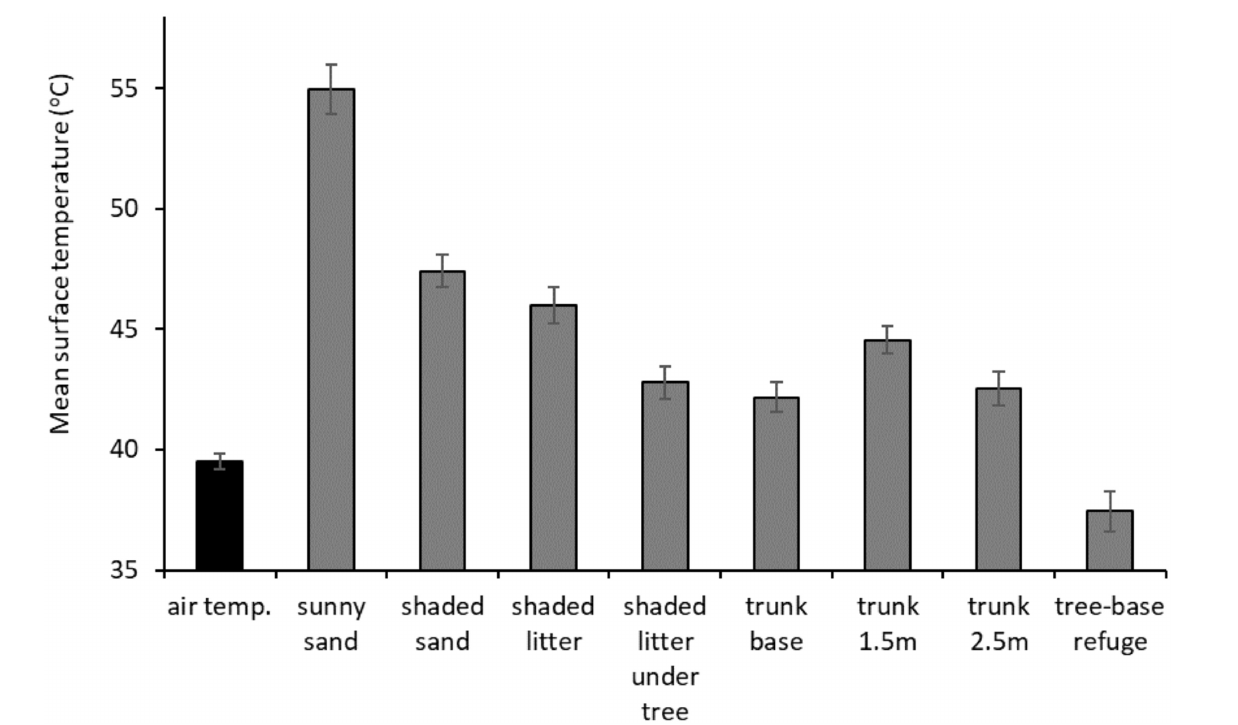
FIGURE 7 | Mean surface temperature of habitat substrates at a mean air temperature of 39.5 ◦ C on sunny afternoons. Error bars show SE. (Repeated ANOVA: F 6 , 81 = 189.1, p < 0.001; Tukey: all pairwise comparisons between substrate categories: p < 0.05, except for shaded litter under tree versus trunk base and trunk at 2.5 m, and trunk base versus trunk at 2.5 m).